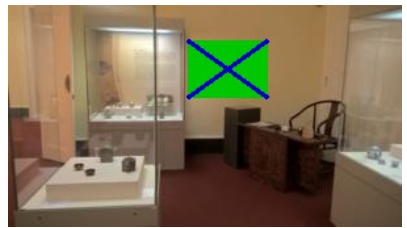
Figure 14. “Cross of thickness 2 in a filled rectangle”.